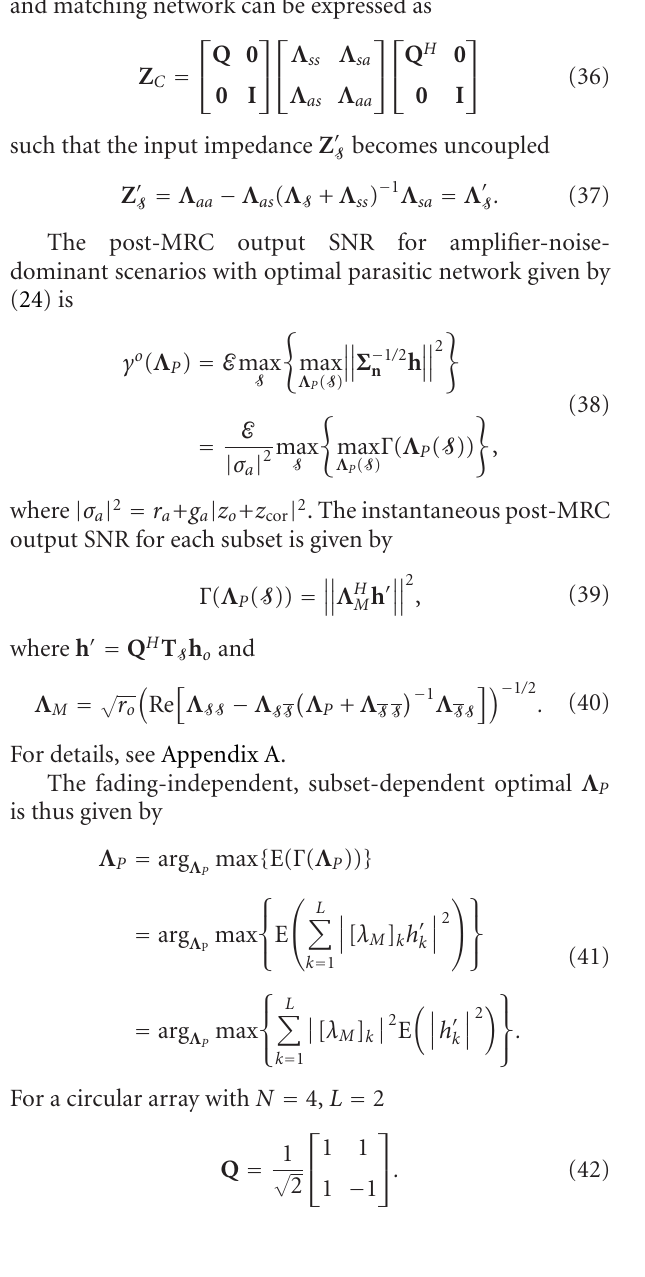
Table 1: Optimal Parasitic Network: Circular Array N = 4, L